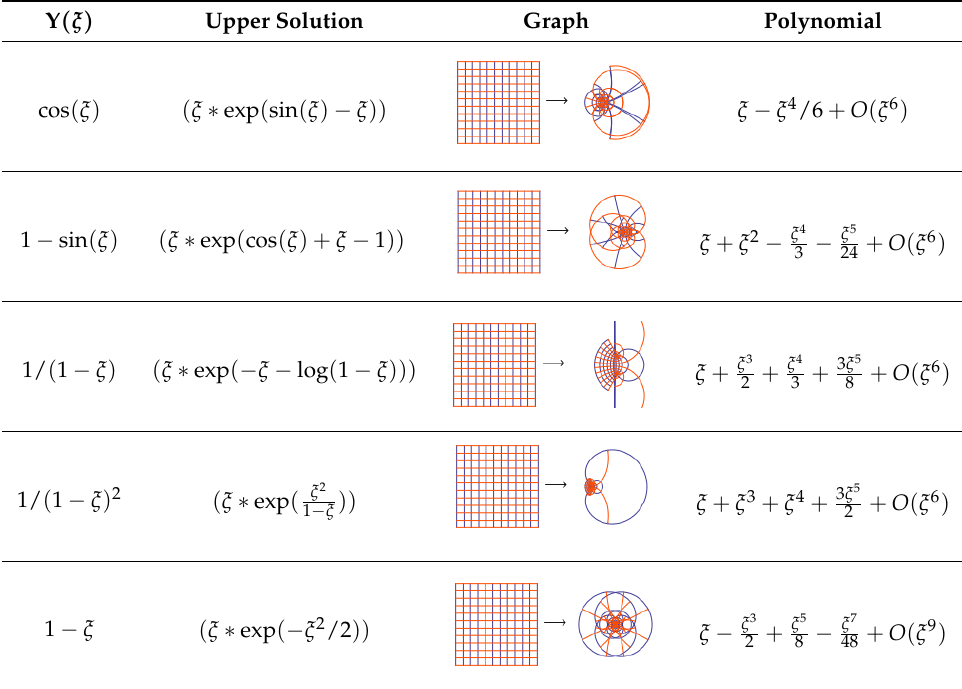
Table 1. The upper bound solution of q-BBE for different Υ ( ξ )